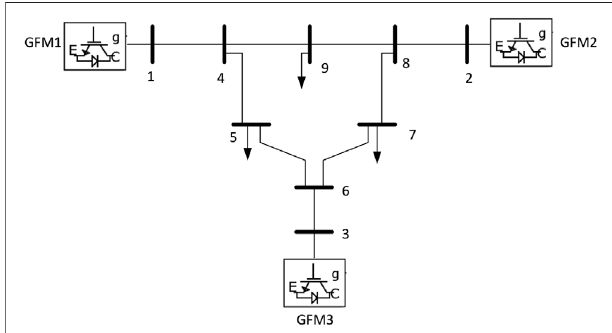
FIGURE 3 | Diagram of in the 9-buses system.